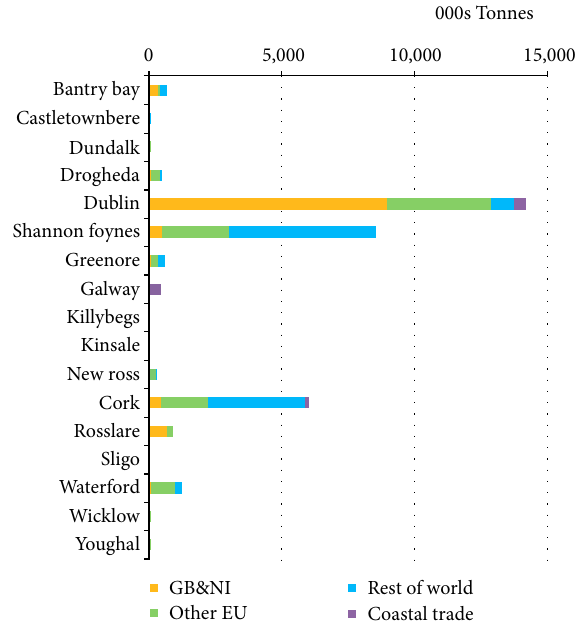
Figure 9: Tonnage of goods received by Irish ports and trade partners in 2015